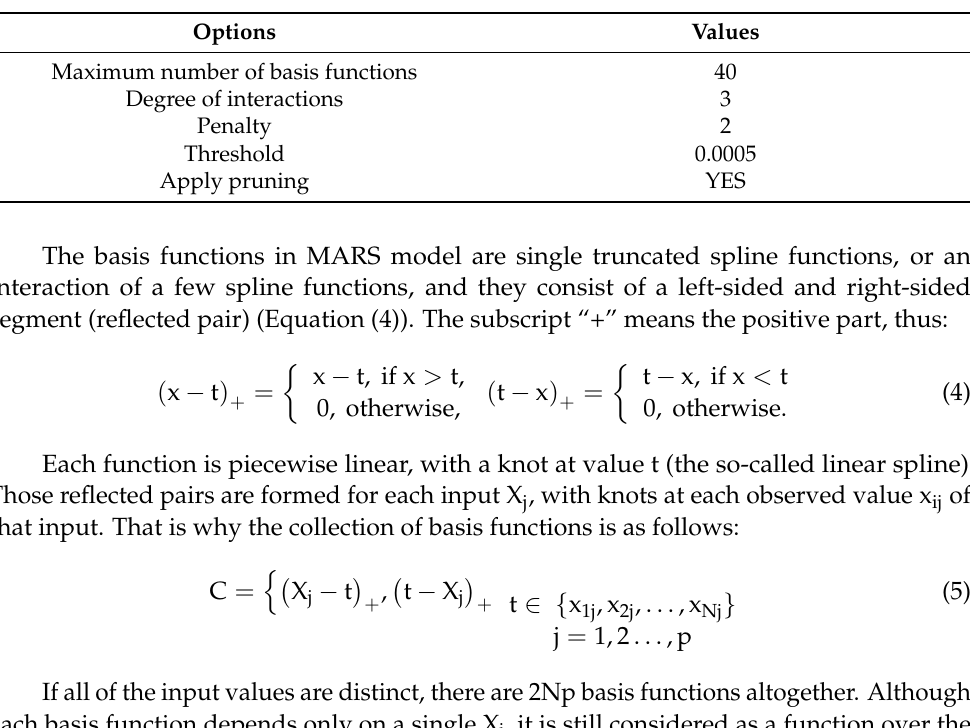
Table 7. Specification of MARSplines